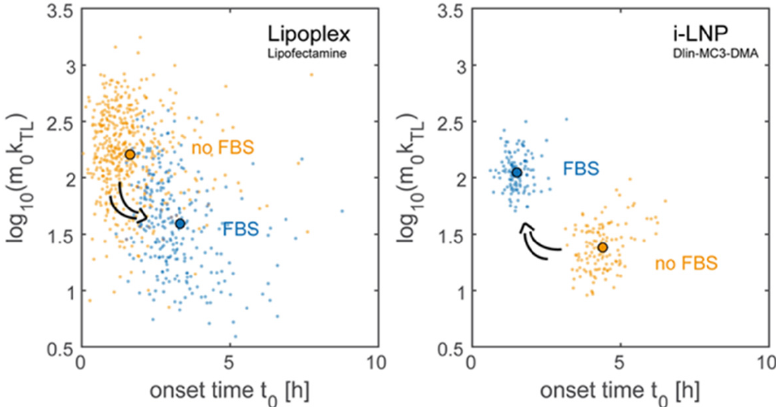
Figure 7. Parameter estimation of single-cell expression time courses using the translation-maturation model. Protein adsorption on the nanocarrier’s surface has the opposite effect on ionizable lipid nanoparticles i-LNPs compared to lipoplexes. Scatterplots of expression onset time t0 vs. expression rate m0kTL of lipoplexes (left) and i-LNPs (right) with (orange) and without serum (blue). The arrows indicate the opposite effect on transfection efficiency and timing induced by addition of FBS. Each data point corresponds to a single cell. The median value is indicated as full dot. Adapted from Reiser et al., [113], Oxford University Press, 2019, under creative common